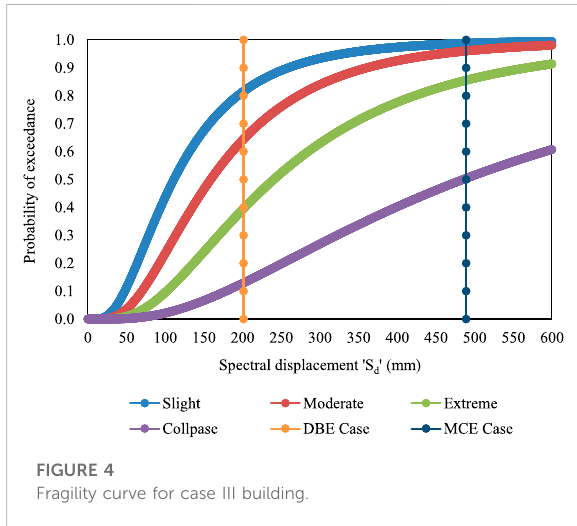
FIGURE 4 Fragility curve for case III